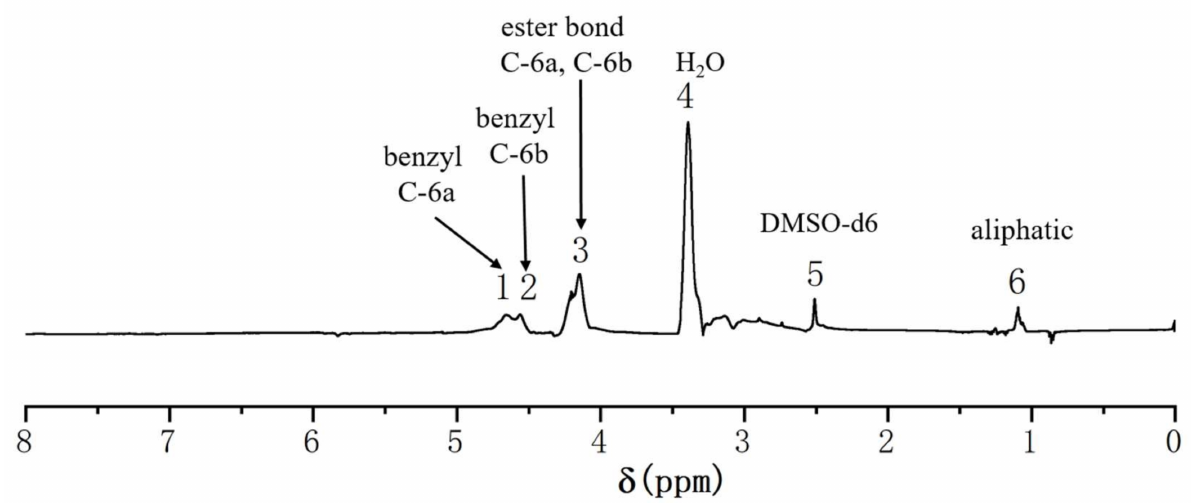
Figure 7. 1 H-NMR differential spectrum of Ac-GML obtained from ginkgo CW-DHP by subtracting the spectrum of Ac-GML-[ 13 C- 2 H] from the spectrum of Ac-GML.